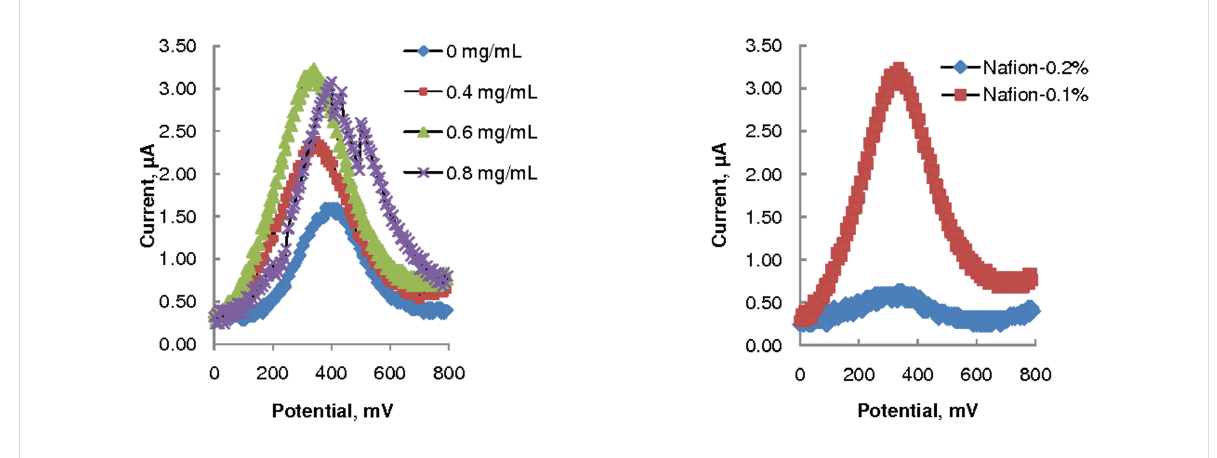
Figure 2: SWV of 1 mmol/L AA (in 0.1M acetate buffer, pH 3.7), scan rate = 75 mV/s: influence of varying the MWCNTs concentration (left) and Nafion concentration (right).